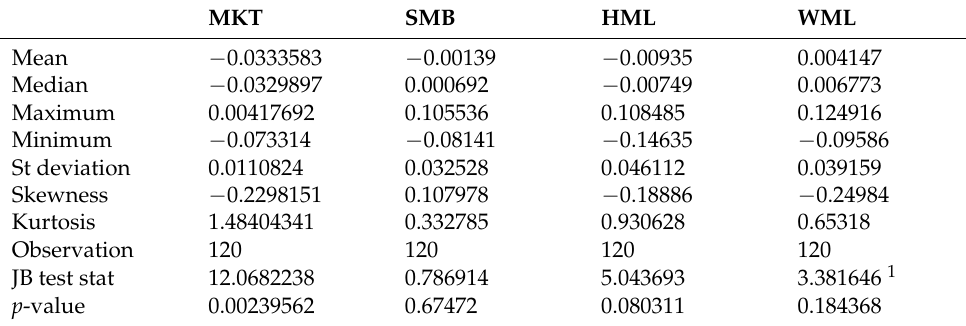
Table 1. Summary statistics of pricing